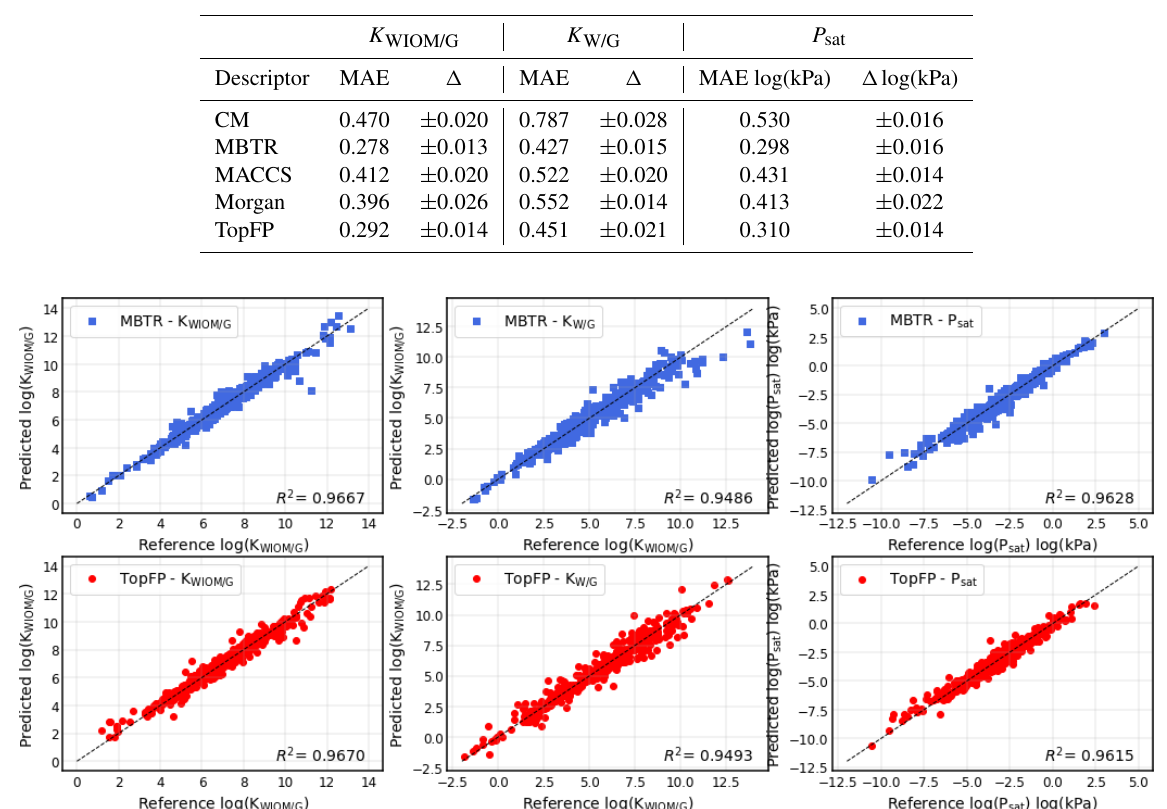
Figure 6. Scatter plots for predictions of the partitioning coefficients of a molecule between water-insoluble organic matter and the gas phase K WIOM/G , water and the gas phase K W/G , and the saturation vapour pressure P sat for the test set of 414 molecules using MBTR (top) and TopFP (bottom). The prediction with the lowest mean average error was chosen for each scatter plot.